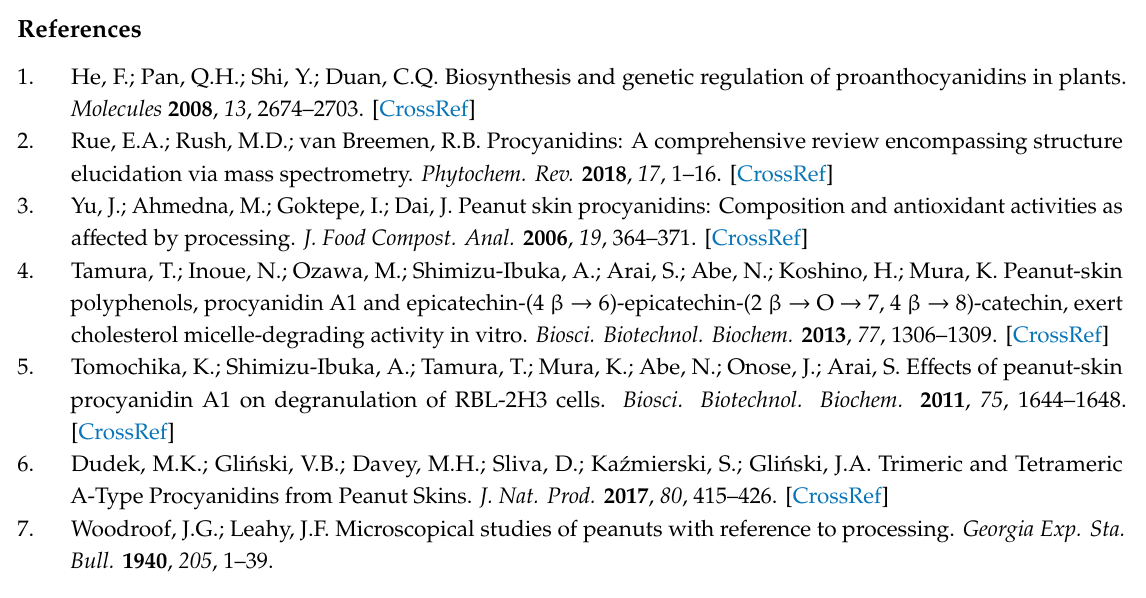
Figure S1: Representative ion images of the assigned flavan-3-ol species in peanut longitudinal sections by matrix-assisted laser desorption / ionization-mass spectrometry imaging. These ion images were obtained from two peanuts di ff erent from that shown in Figure 3. The dotted white line shows the analyzed region. Scale bar = 2